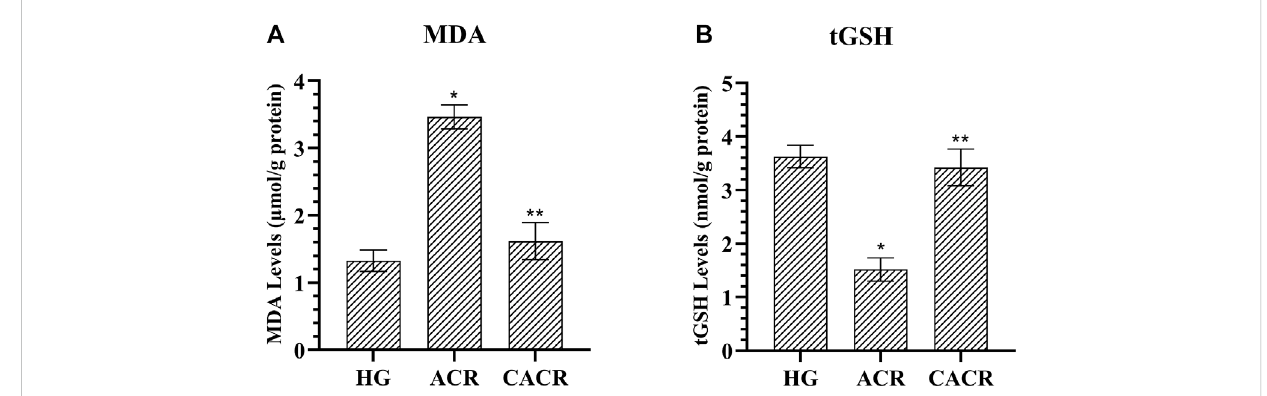
FIGURE 1 (A,B) AnalysisofMDAandtGSHlevelsinlivertissuesofratsinexperimentalgroups.n=6/eachgroup.Thebarsshowthemean±standarddeviation. * p < 0.05, ACR group is compared with the HG and CACR groups. ** p > 0.05, CACR group is compared with the HG group.